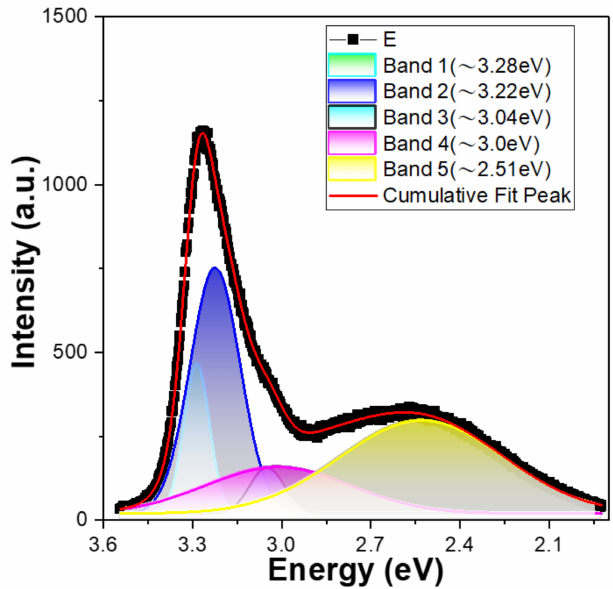
Figure 7. PL spectrum of 10 min-synthesized ZnO NFAs and the fitting results using the sum of five Gaussian